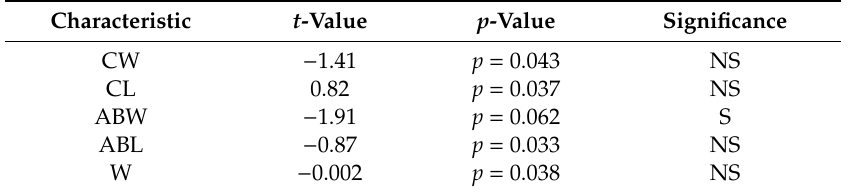
Table 4. The values of Student’s two-sample t -tests, comparing all characteristics between sexes. Characteristic t -Value p -Value Significance CW − 1.41 p = 0.043 NS CL 0.82 p = 0.037 NS ABW − 1.91 p = 0.062 S ABL − 0.87